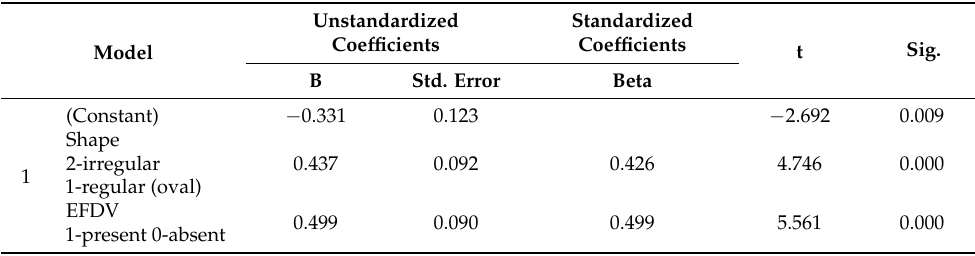
Table 4. Significant predicting parameters of HR GIST according to the multivariate logistic regression